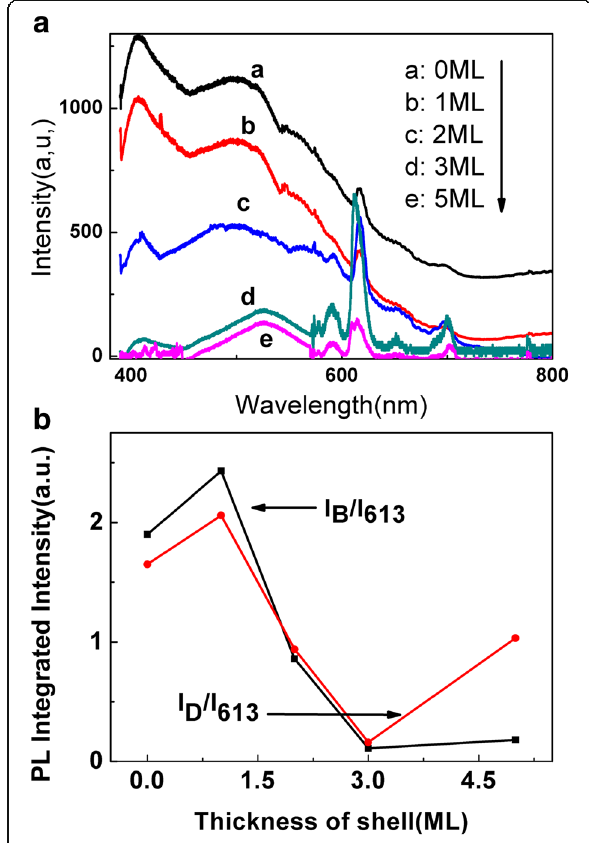
Fig. 2 a PL spectra of core-shell ZnSe:Eu/ZnS QDs with different shell thicknesses. b Comparison of PL intensity ratio of Eu ( I 613 ) to the band edge ( I B ) of the ZnSe quantum dot as well as the defect-related ( I D )